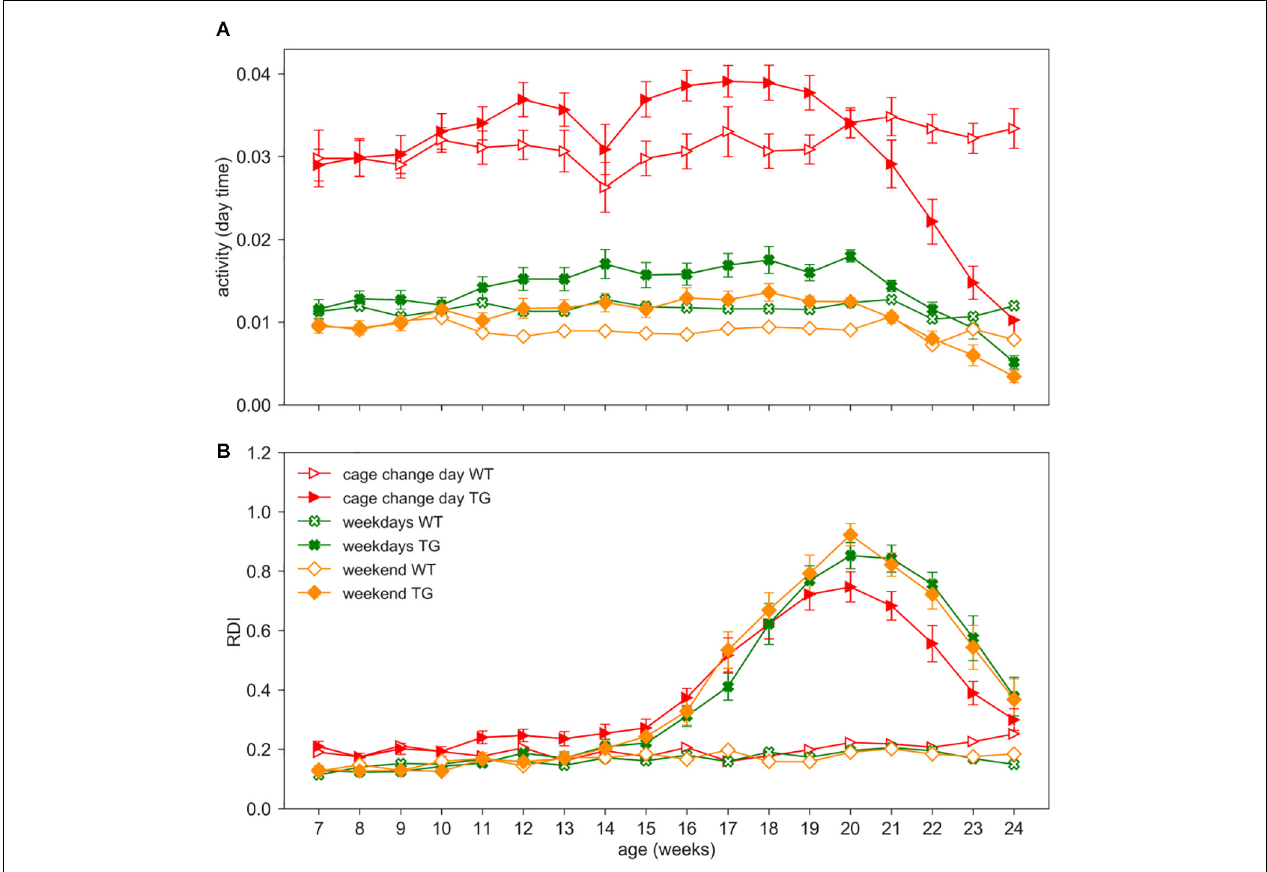
FIGURE 7 | Impact of procedures. Day time activity (A) and RDI (B) curves across weeks 7–24 in WT (open symbols) and TG (filled symbols) (males and females) during cage change days (red triangles), weekdays (green crosses, 2 days in which procedures as grid test or body weight assessment were performed) or weekends (orange diamonds, Saturday and Sunday, without procedures). Data are mean ± SEM. N of cages per group: WT = 19; TG = 19. No differences were observed in RDI between weekdays and weekends in both genotypes. RDI is not influenced by personnel activity in the room nor by experimental